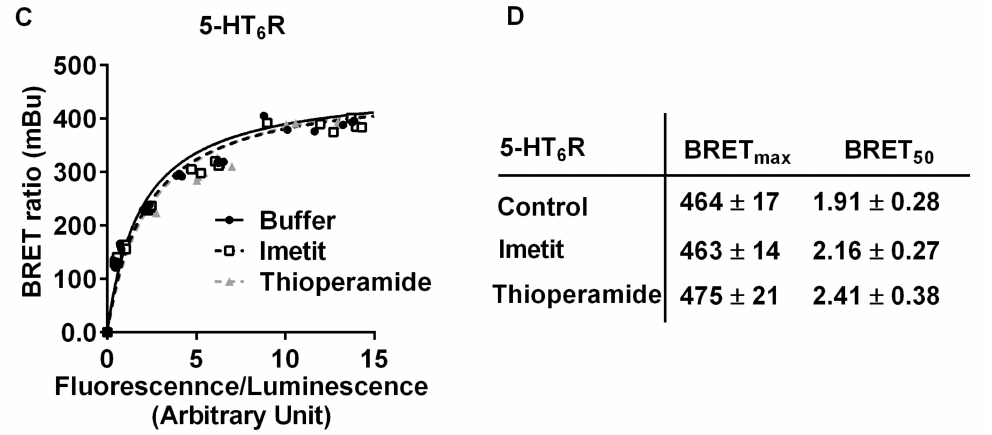
Figure 4. BRET saturation curves of homodimerization of H 3 R and 5-HT 6 R in HEK-293 cells. ( A ) BRET signals were performed on HEK 293 cells transiently transfected with a constant DNA amount of H 3 R-RLuc ( A ) or 5-HT 6 -RLuc ( C ) and increasing quantities of, respectively, H 3 R-YFP ( A ) or 5-HT 6 -YFP ( C ). BRET signals were determined in the absence (control) or presence of 100 nM of the H3R agonist (imetit) or 100 nM of the H 3 R inverse agonist (thioperamide). The curves were fitted using a non-linear regression equation assuming a single binding site (GrapPadPrism). The goodness of fit was given by r 2 values that were very close to unity in each dose–response curve: r 2 = 0.928, 0.926, and 0.928 for control, imetit, and thioperamide, respectively. Data were obtained from three separate experiments with triplicate determinations. ( B , D ) Parameters derived from BRET saturation curves of the homodimerization of H 3 R ( A ) or 5-HT 6 R ( B ) in the absence or presence of imetit or thioperamide. Data were analyzed by two-way ANOVA as follows: factor BRET level F(13, 42) = 195.5, p < 0.0001; factor treatment F(2, 42) = 104.1, p < 0.0001; and interaction F(26, 42) = 3.53, p =